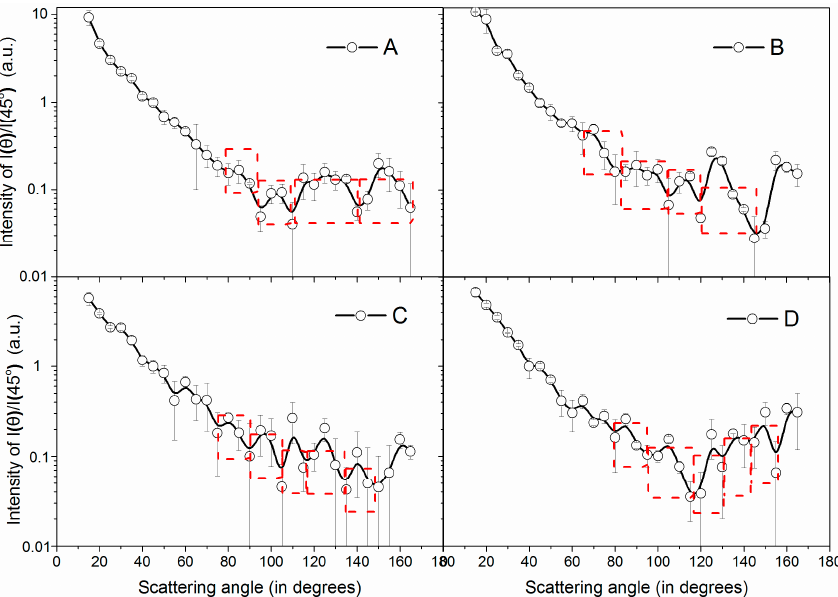
Figure 12. The measured angular distributions of the scattering light (45 ◦ as a reference) for the four particle samples A, B, C, and D.